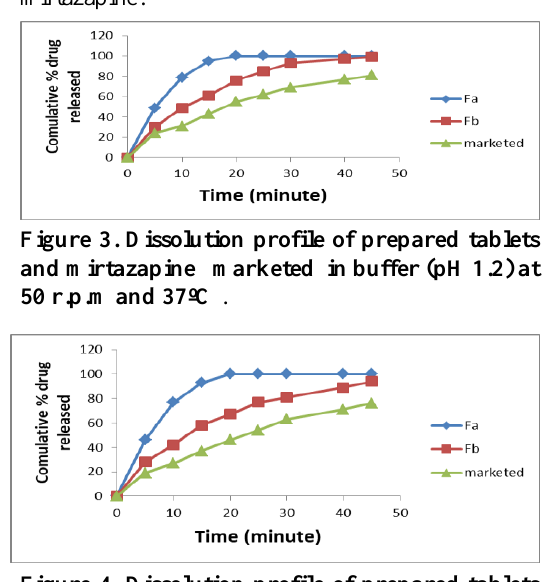
Figure 4. Dissolution profile of prepared tablets and mirtazapin marketed in buffer (pH 6.8) at 50 r.p.m and 37ºC.